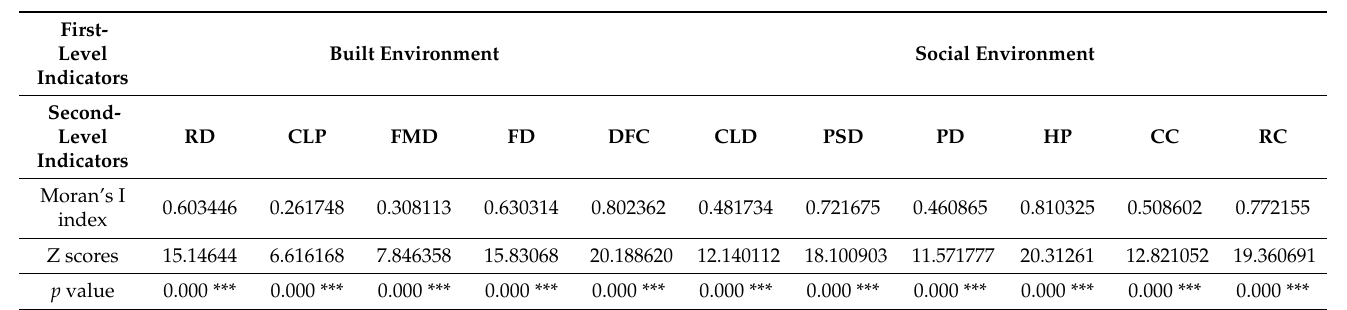
Table 3. Statistics of spatial autocorrelation results of influencing mechanism of station area accessi- bility.